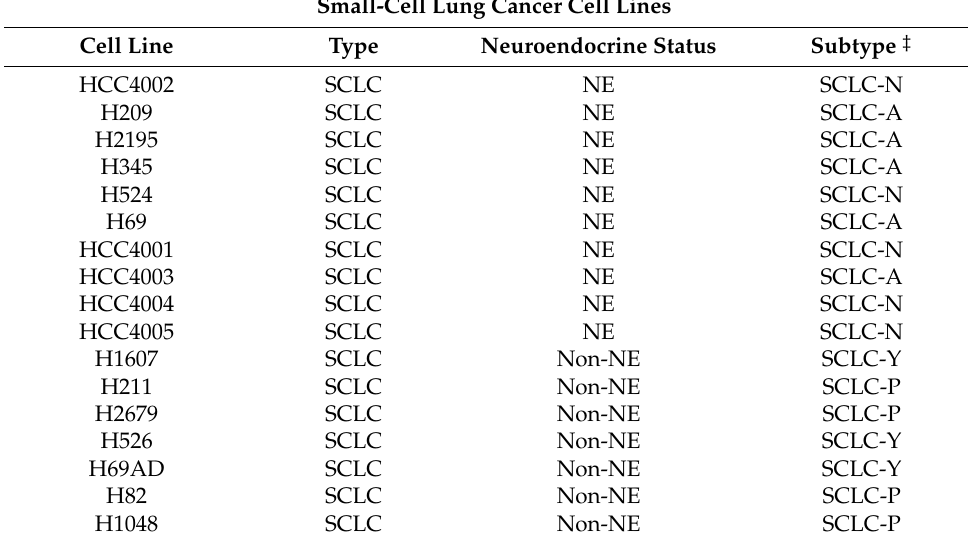
Table A1. Description of SCLC Cell